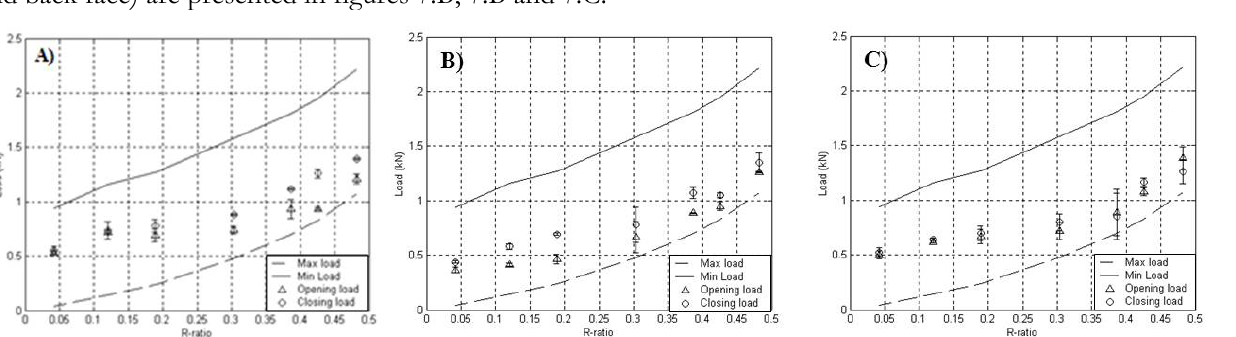
Figure 7: A) Illustration showing the variation of the opening and closing loads with the R-ratio for a 42 mm crack using a horizontal strain gauge, B) a 45 ˚ strain gauge, C) a back face strain